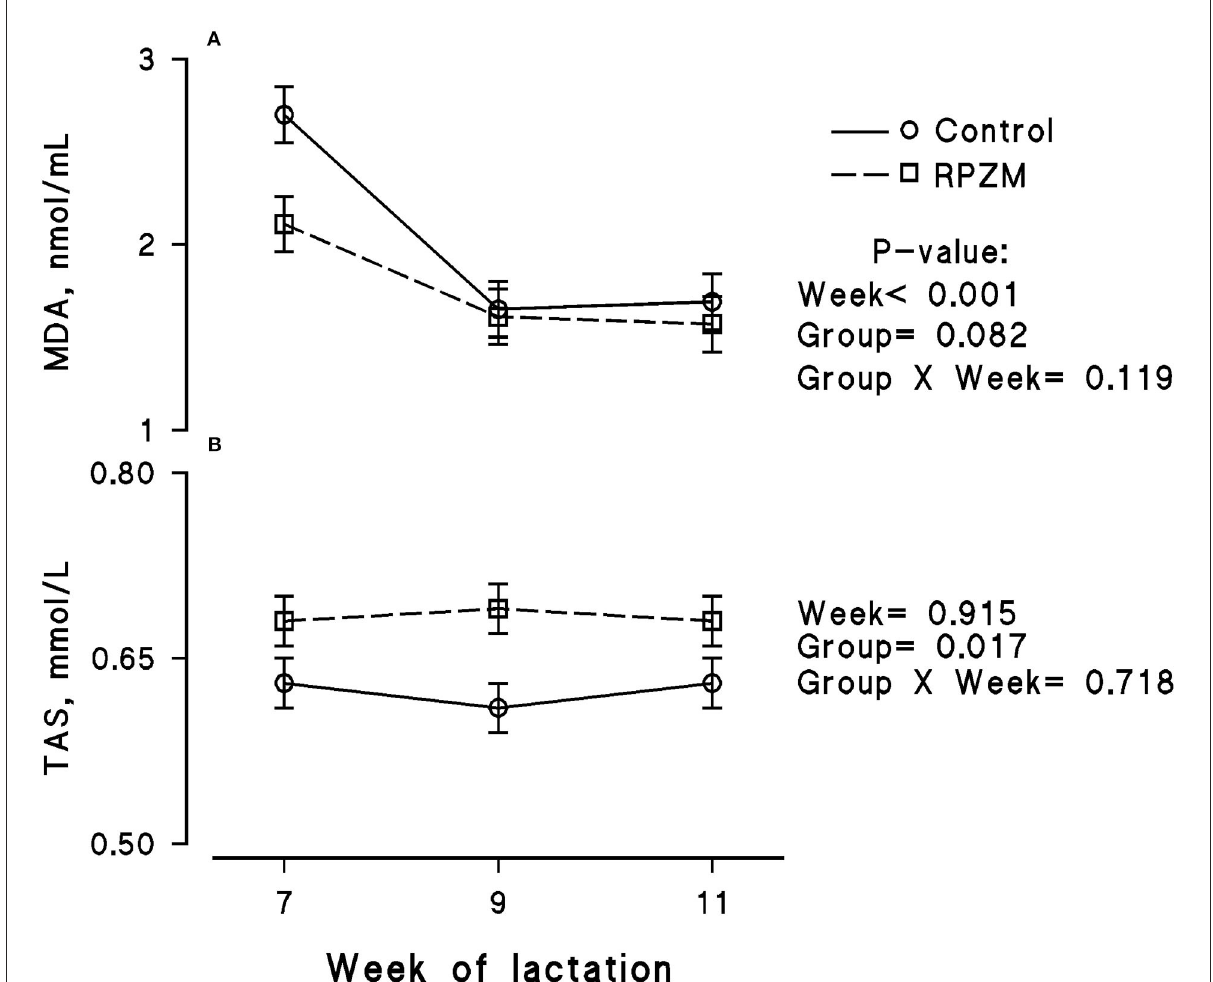
FIGURE7 Blood serum concentration of malondialdehyde (MDA; A ) and total antioxidant status (TAS; B ) of high-producing Holstein cows, through lactation weeks 6–11, supplemented without (control) or with rumen-protected zinc–methionine complex (RPZM) during long-term environmental heat stress. Values are means ± standard error of